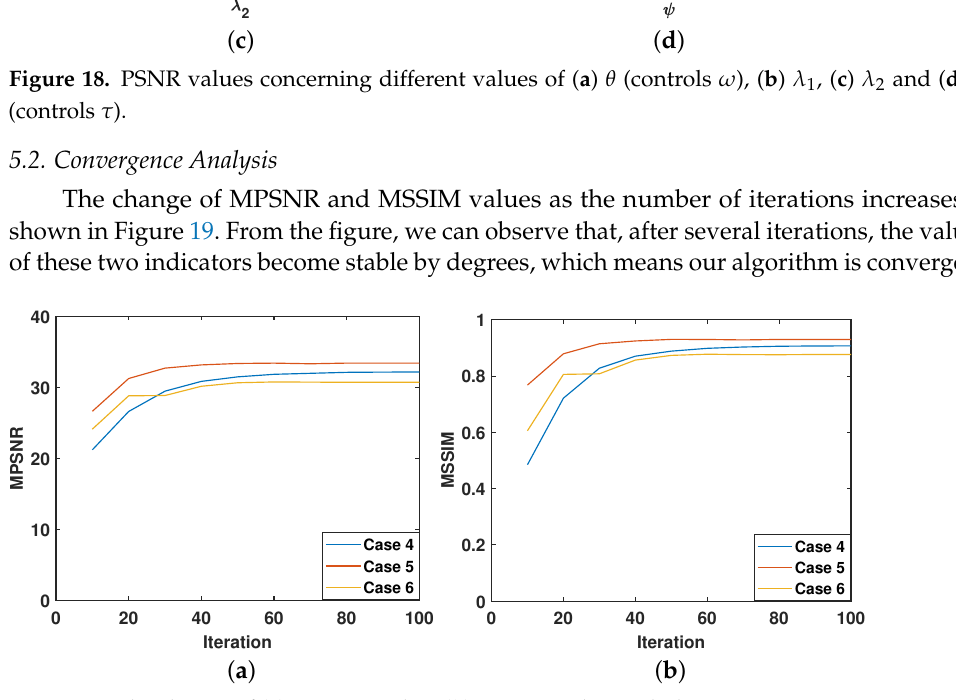
Figure 19. The change of ( a ) MPSNR value, ( b ) MSSIM value with the